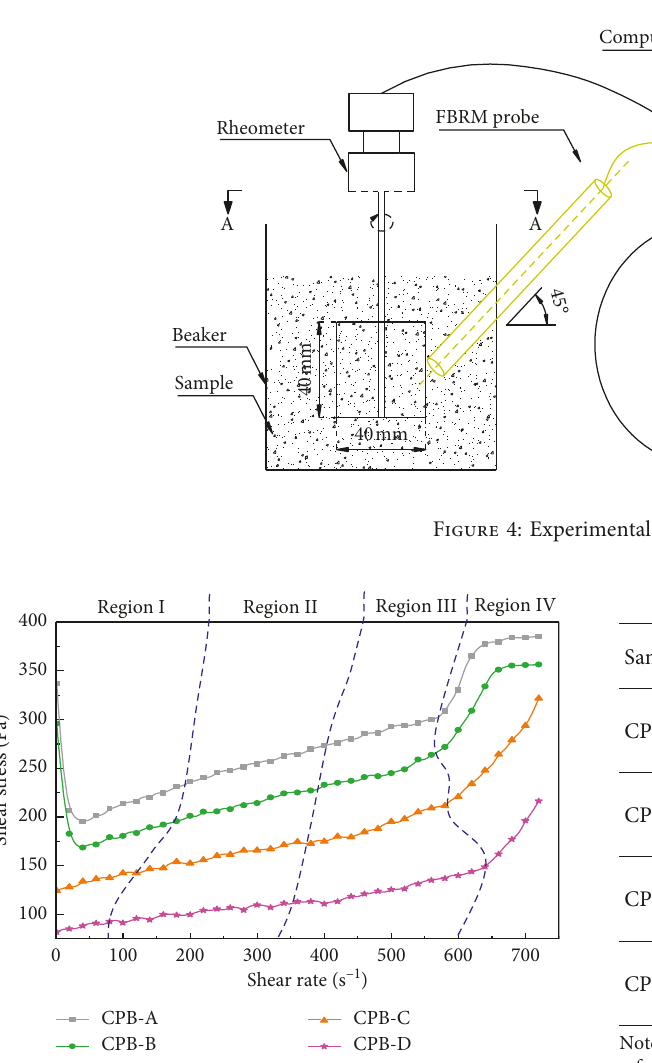
Figure 5: Influence of shear on flow curve behavior of CPB depending on different regions.